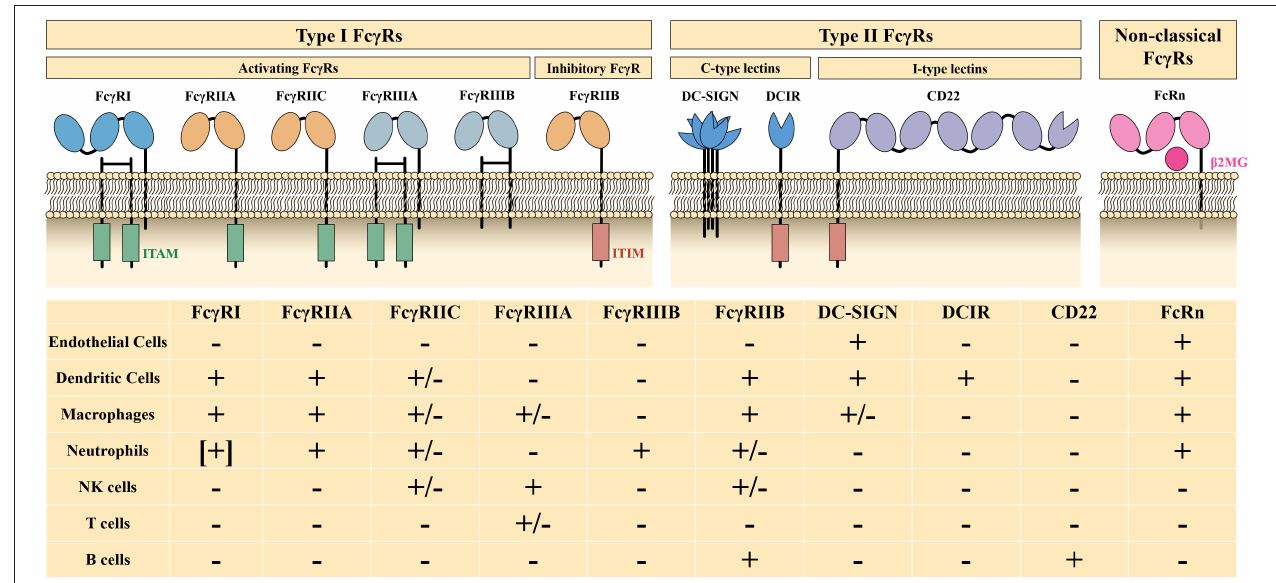
FIGURE 2 | Characteristics and distribution profiles of human Fc γ Rs. ITAM, immunoreceptor tyrosine-based activation motif; ITIM, immunoreceptor tyrosine-based inhibition motif; β 2MG, β 2-microglobulin; + , generally expressed on cells; –, not expressed on cells; [ + ], expressed on induced cells, + /–, expressed on specific genotype or subset of cells. Part of this figure has been adapted with permission from Springer Nature Customer Service Centre GmbH: Springer Nature: Nature Reviews Immunology, 13(3):176-89: Intravenous immunoglobulin therapy: how does IgG modulate the immune system?, by Inessa Schwab et al., 2013.